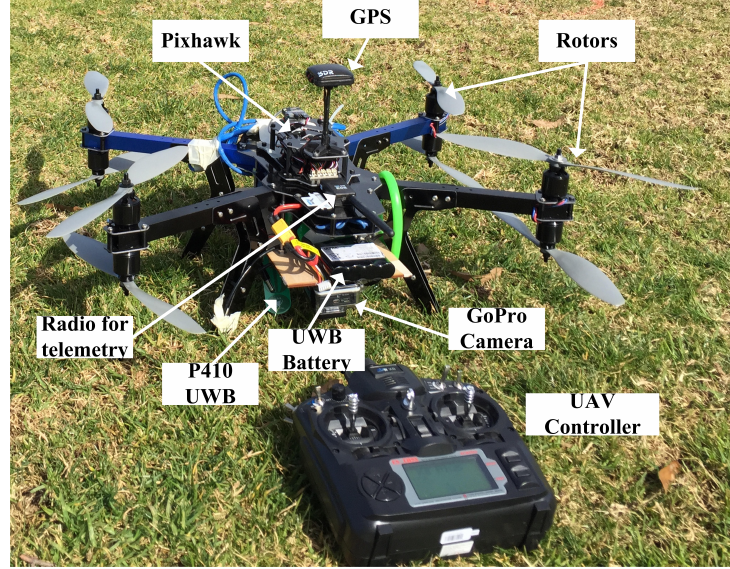
Figure 3. Image showing one of the developed UAV prototype in a cooperative swarm. Table 1. Details of sensors installed on the UAVs